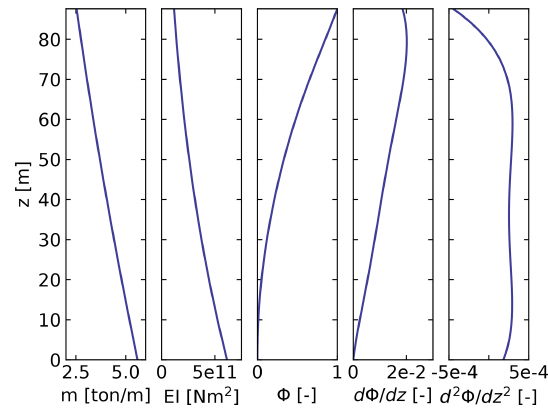
Figure 5. Properties of the NREL 5MW turbine tower: mass per length ( m ), bending stiffness (EI), shape function displacement ( (cid:56) ), slope ( d(cid:56)/ d z ), and curvature ( d 2 (cid:56)/ d z 2 ).